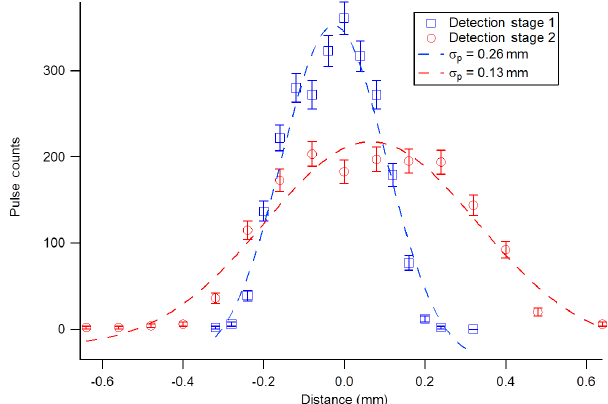
Figure 7. Gaussian particle beam profiles obtained using the optical characterisation method. Measurements were made using a beam of 600nm PSL at detection stage 1 and detection stage 2 at a distance of 125 and 240mm from the aerodynamic lens nozzle respectively. Error bars are 1 σ standard errors, assuming Poisson